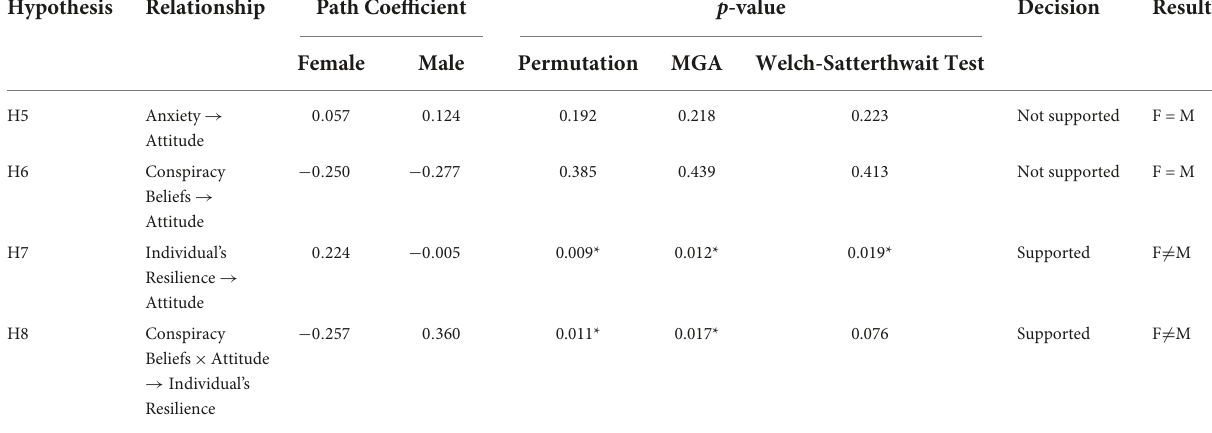
TABLE 8 Results of hypotheses testing for multigroup